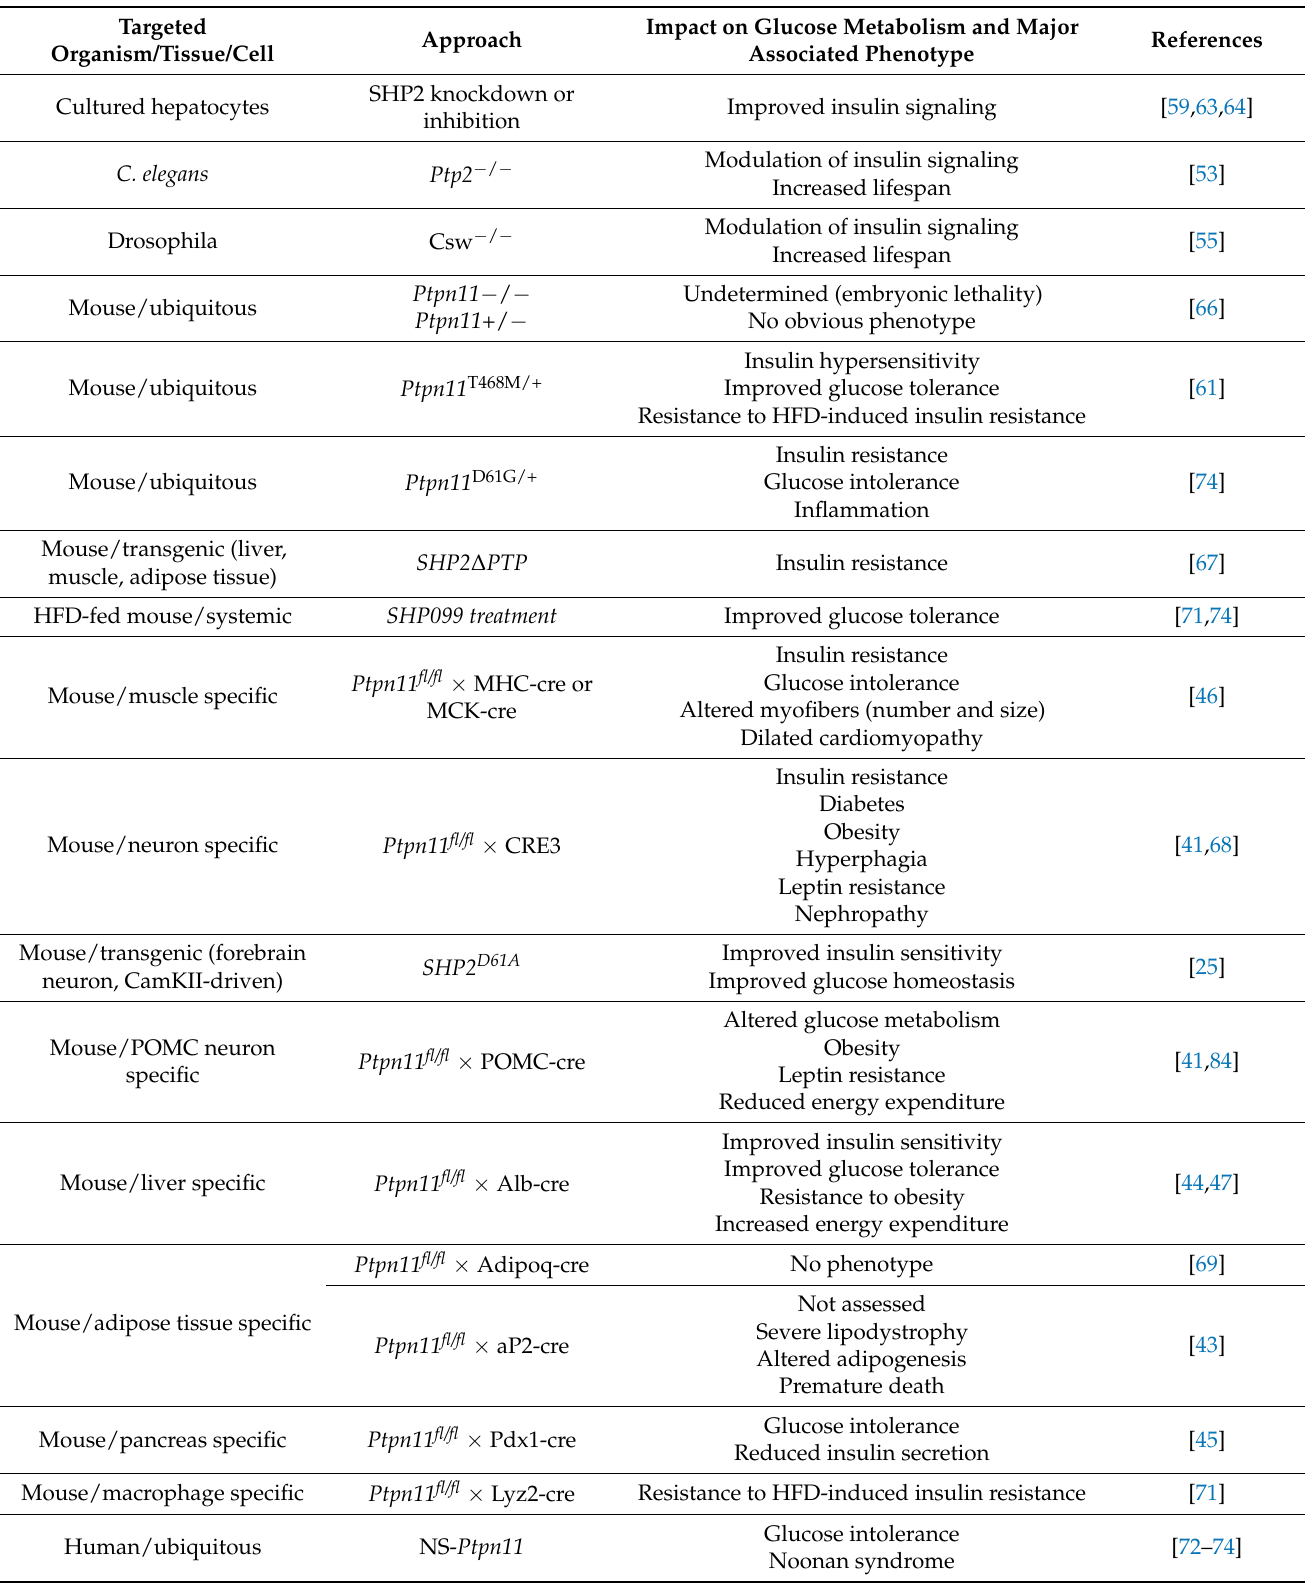
Table 1. Impact of SHP2 dysregulation on insulin